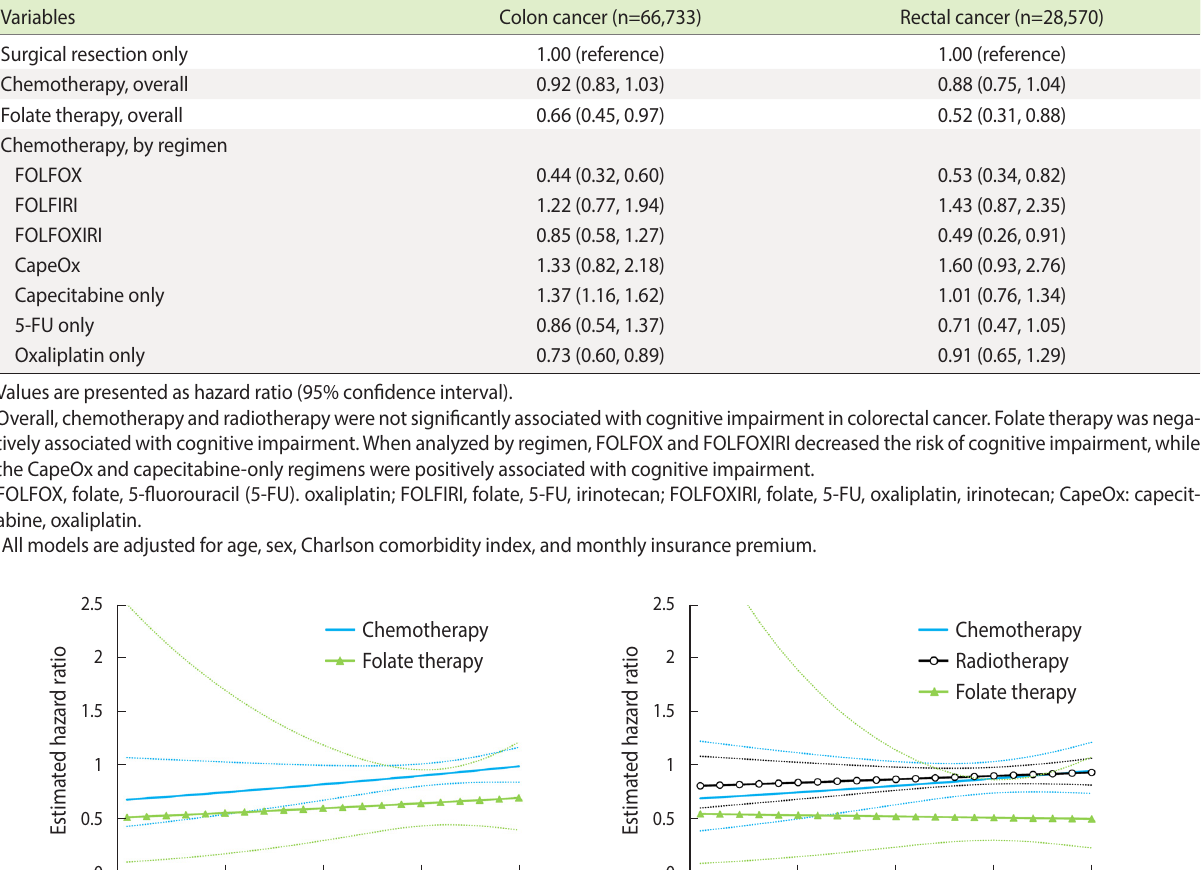
Table 2. Estimated hazard ratios of chemotherapy regimens and radiotherapy on cognitive impairment (n=95,303) 1 Variables Colon cancer (n=66,733) Surgical resection only Chemotherapy, overall